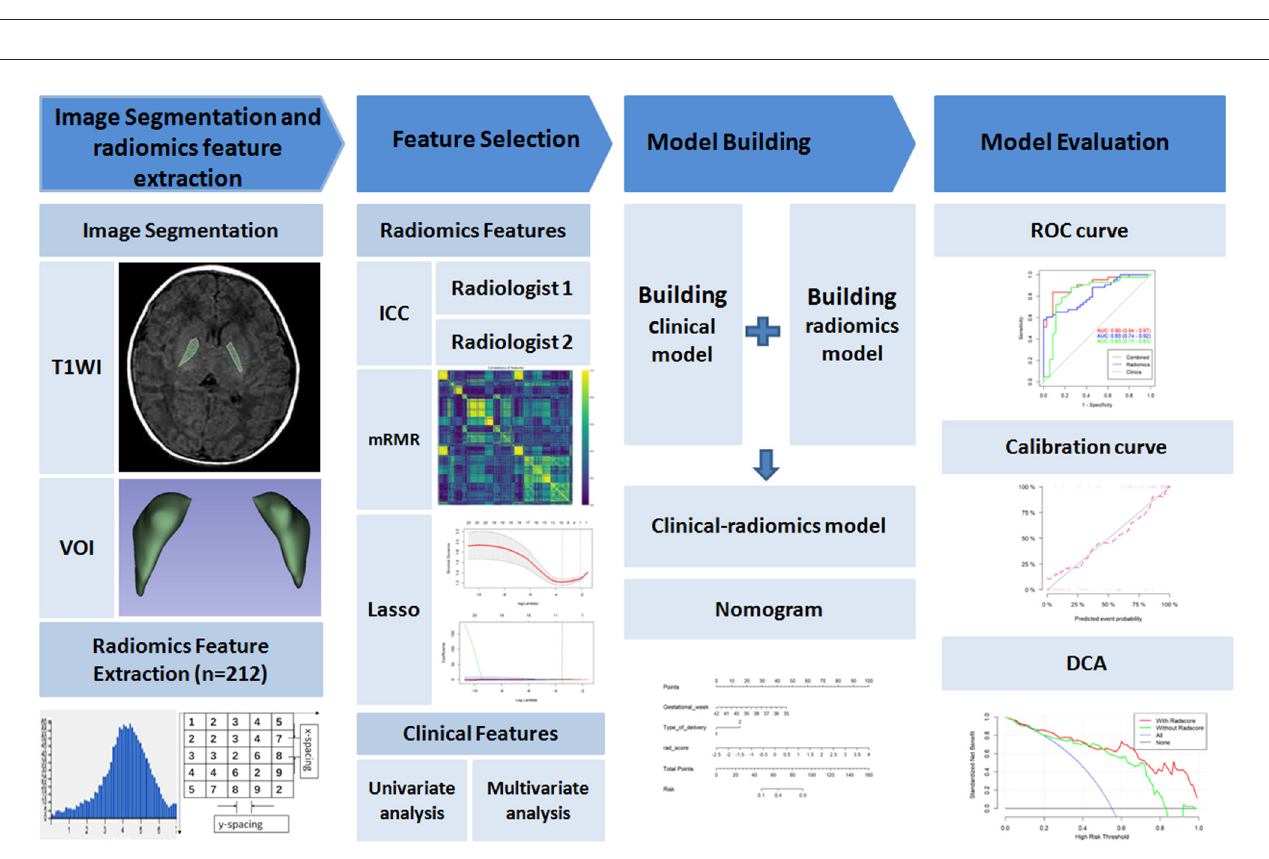
FIGURE2 The workflow of clinical-radiomics analysis in the current study. VOI, volume of interest; ICC, intraclass correlation coefficients; mRMR, maximal relevance and minimal redundancy; Lasso, least absolute shrinkage and selection operator; ROC, receiver operating characteristic; DCA, decision curve analysis.